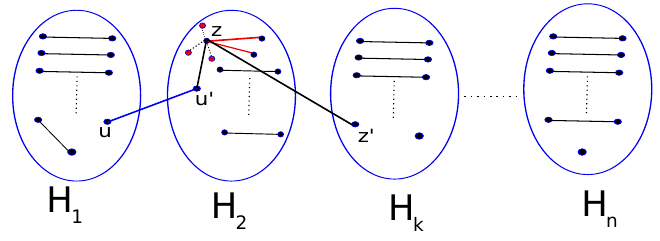
Figure 2: Case 2.2.1: | F V